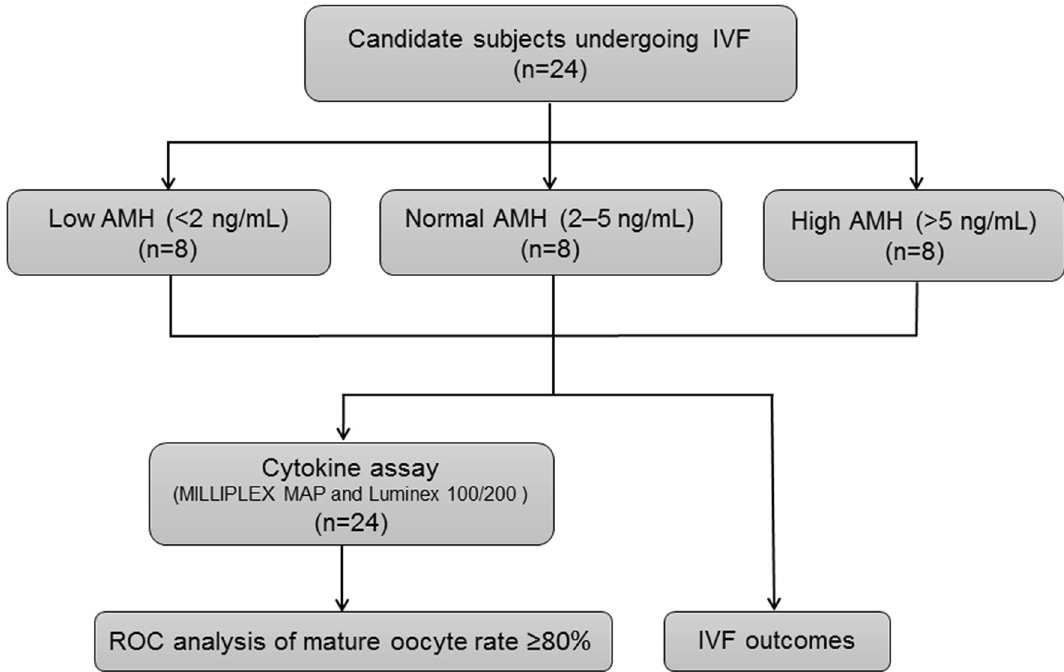
Figure 1. Flowchart of study design. 24 infertile women under IVF treatment were recruited and divided into three groups (low ovarian reserve, < 2 ng/mL; normal ovarian reserve, 2–5 ng/mL; and high ovarian reserve, > 5 ng/mL) according to ovarian reserve (serum AMH level). Cytokine analyses were performed on these three